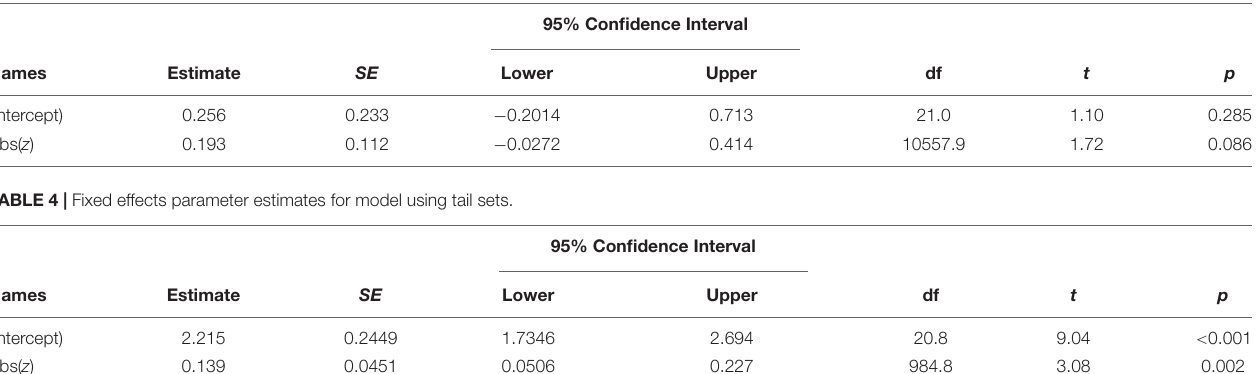
FIGURE 4 | Predictions from the probabilistic and categorical account together with results showing the correspondence between the functional form of the NLR and the distribution of the data. (A) The red and blue curves illustrate predicted negative NLR for the probabilistic and categorical accounts, respectively. (B) Box plot of individual adjusted r 2 for the fit of the normal (probabilistic) and square curves (categorical) in Experiment 1A. The normal curve provided a significantly better fit than the square (paired t -test, p < 0.001). (C) Box plot of individual adjusted r 2 for the fit of the normal (probabilistic) and square curves (categorical) in Experiment 1B. The normal curve provided a significantly better fit than the square (paired t -test, p < 0.001). TABLE 3 | Fixed effects parameter estimates for model using reference set.